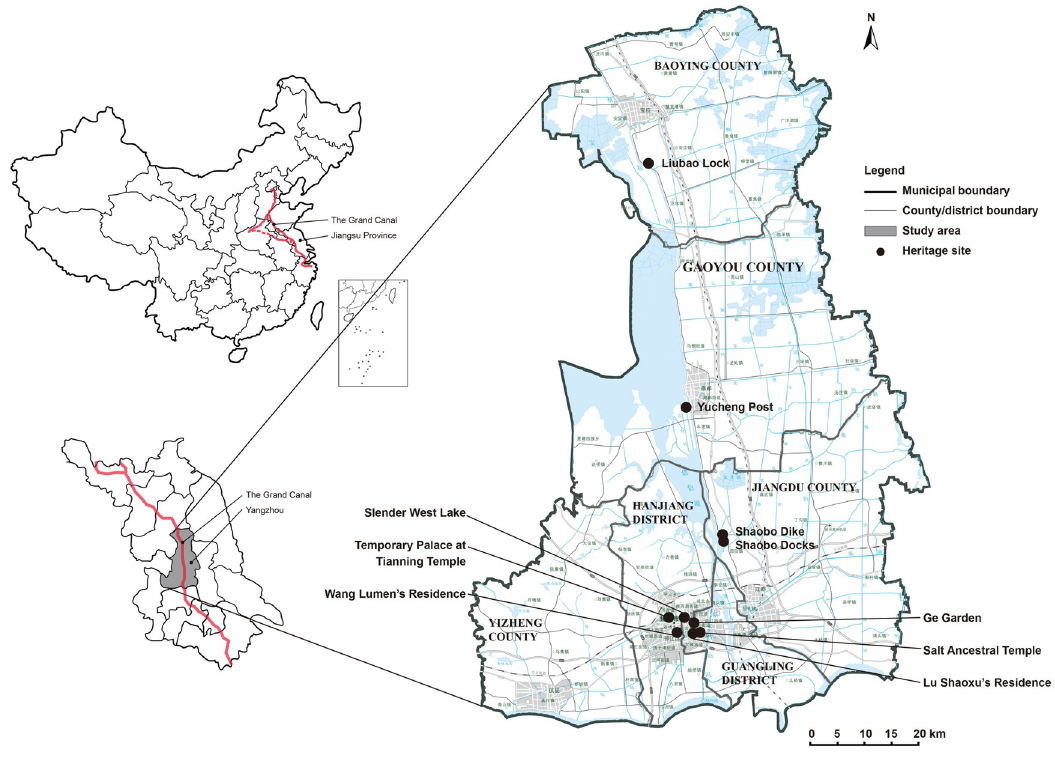
Fig 2. Location map of the study